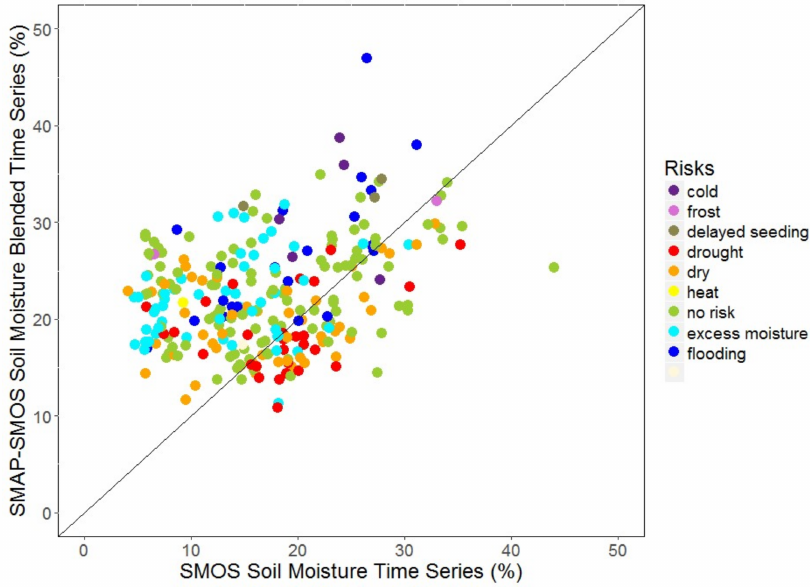
Figure 5. Comparison of monthly soil moisture (volumetric) retrieved from a blended SMAP-SMOS time series and a SMOS-Only time series under different risk conditions as evaluated from expert reports. Data are aggregated to monthly time